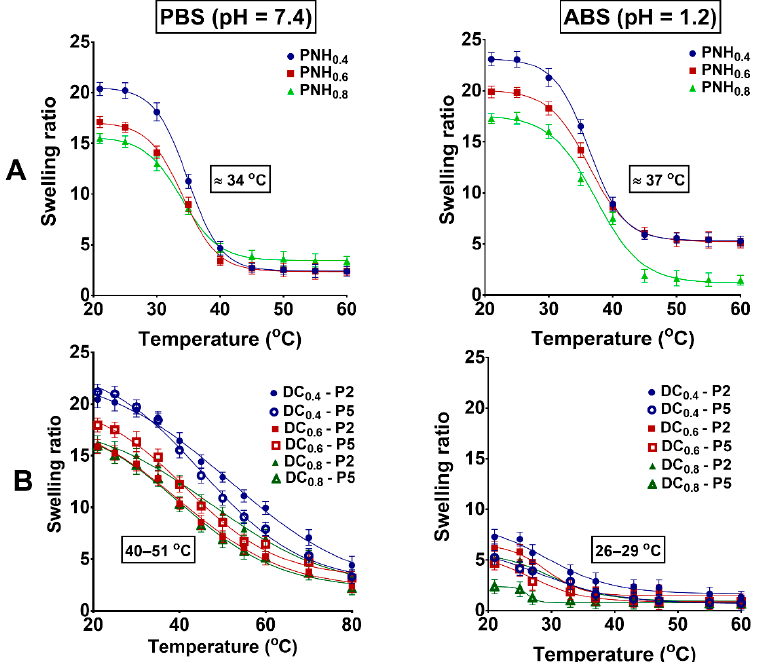
Figure 4. Swelling ratios of conventional ( A ) and DC ( B ) hydrogels as a function of temperature measured in simulated physiological conditions.